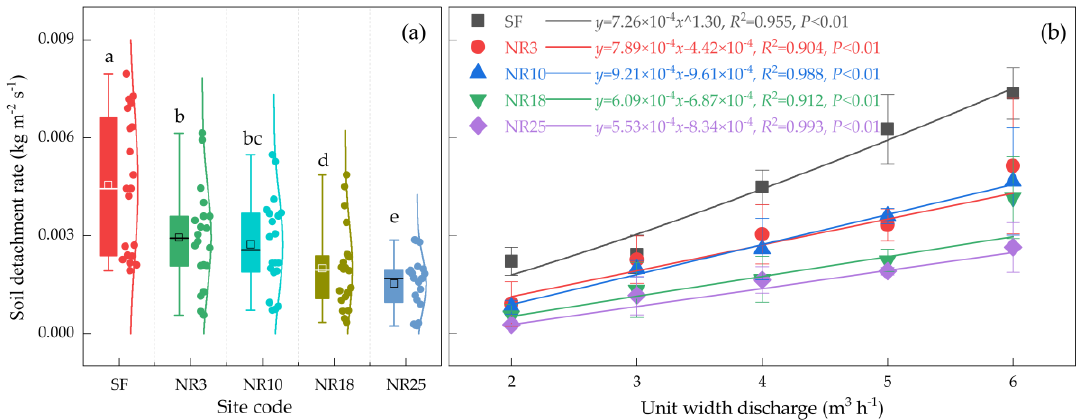
Figure 5. Change in soil detachment rate of gully heads with restoration age ( a ), and its relationships with flow discharge ( b ). Note: Bar means the 95% confidence interval (95% CI). SF refers to the slope farmland. NR3, NR10, NR18, NR25 represents the 3, 10, 18 and 25 years of revegetation age, respectively. The different lowercase letters indicate a significant difference among different revegetation ages ( p < 0.05). ( a ) Site code; ( b ) Unit width discharge. Table 2. Summary of two-way ANOVAs tests.